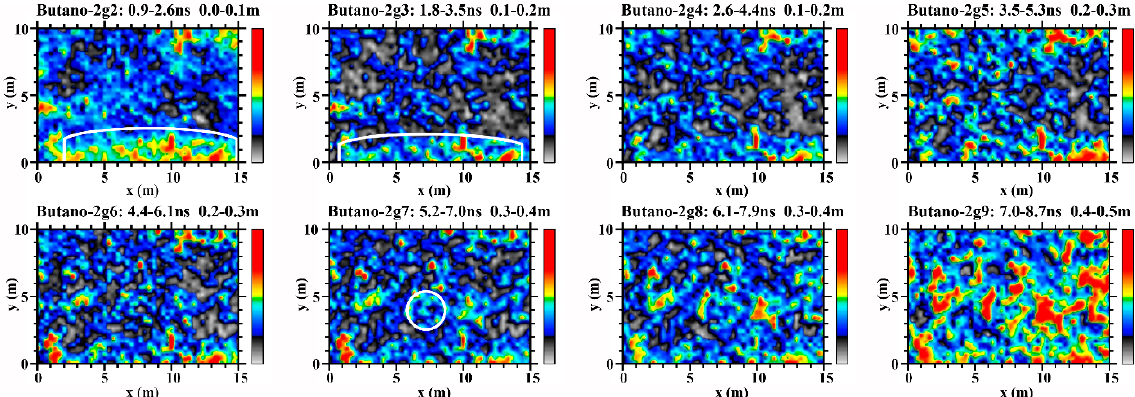
Figure 6. Ground-penetrating radar depth slice comparisons for grid 2. Scale represents the gains-adjusted amplitude time slice parameter for 32-bit data . slice parameter for 32-bit